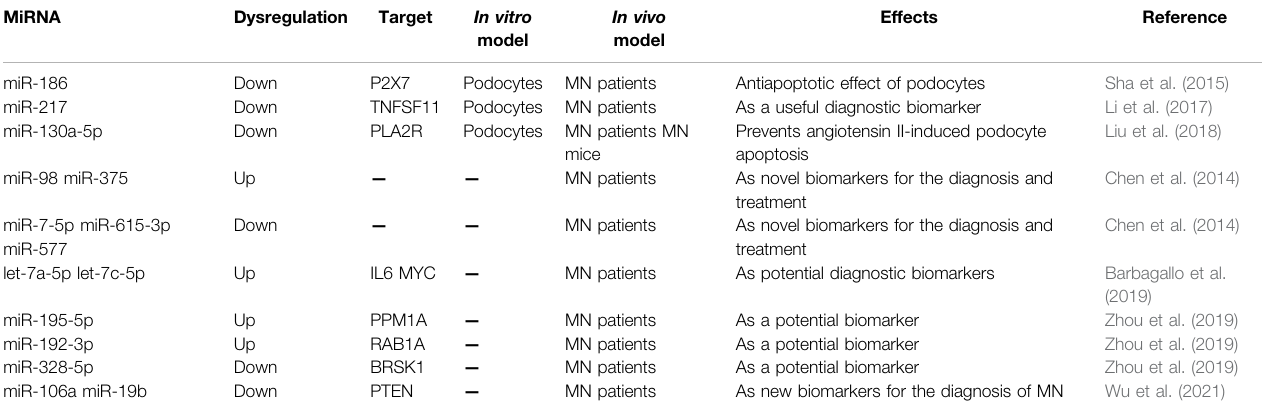
TABLE 3 | MiRNAs in membranous